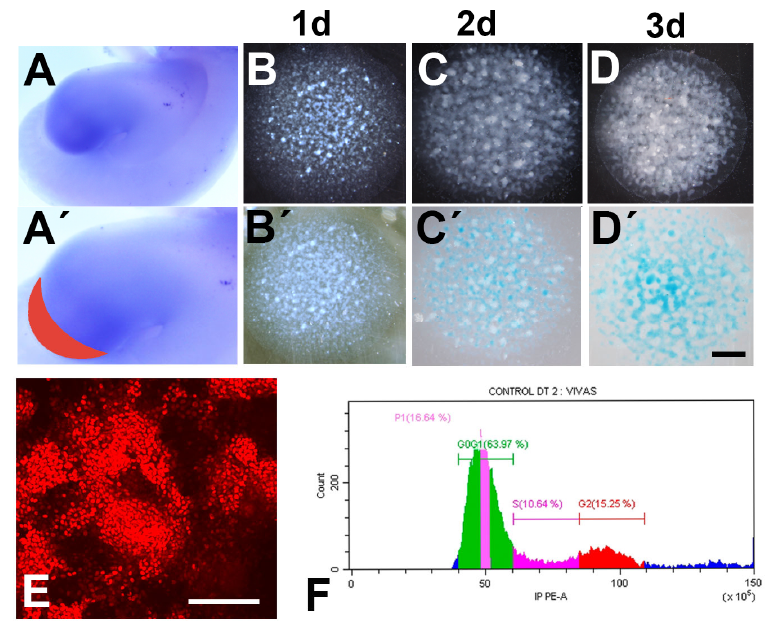
Figure 1. ( A–A’ ) In situ hybridization of the embryonic leg bud at stage 25, showing the expression of HoxA13 . A’ the tissue selected for the experiments is illustrated in red. ( B–D) are dark field low magnification views of micromasses cultured for 24 ( B ), 48 ( C ), and 72 h ( D ). ( B’ – D’ ) illustrate the same cultures after Alcian blue cartilage staining. Note the appearance of Alcian blue-positive nodules on Day 2 of culture. ( E ) 3-day-old micromass section immunolabeled for SOX9. ( F ) Flow cytometry histogram showing the cell cycle of 2 days cultures grown in DMEM. Scale bar in B – D’ = 1 mm; scale bar in E= 100 μ m.